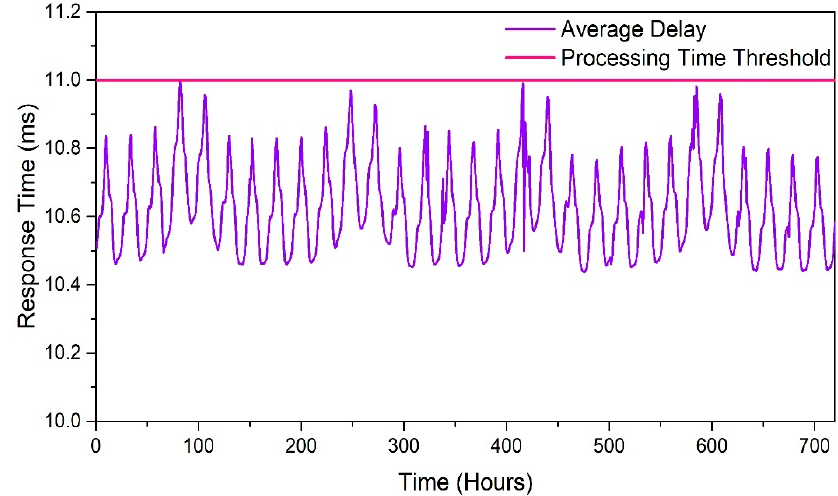
Figure 5. Average daily delay of RLB-Option.